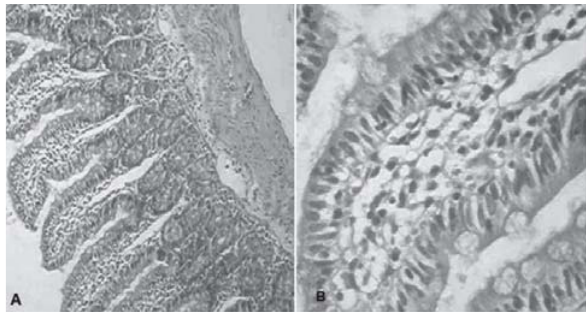
Fig. 2 - Fotomicrografia do grau 0 da classificação de Chiu et al. [6] (HE, A x 100, B x 400) - rato 1 do grupo B